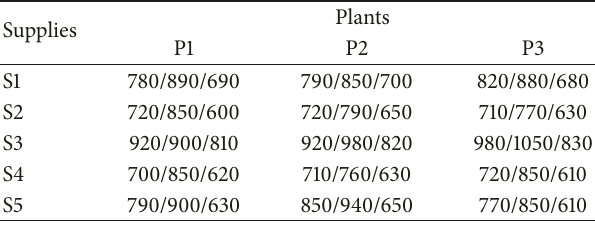
Table 3: Distance from suppliers to plants by different transport modes